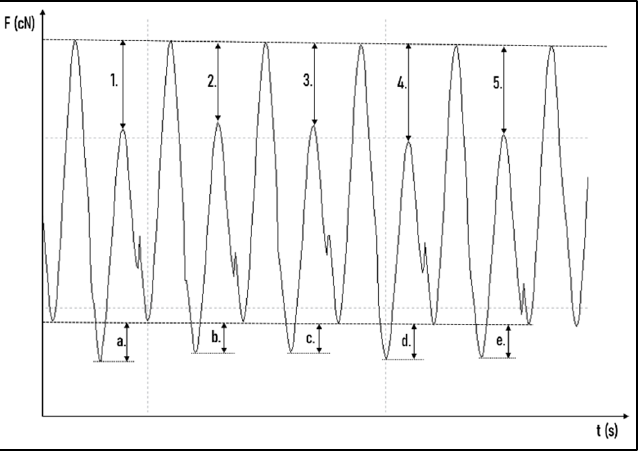
Figure 3. Determination of individual tensile forces. The tensile force of the first (1.), the second (2.), the third (3.), the fourth (4.), and the fifth (5.) ligature at 40 mm and the tensile force of the first (a.), the second (b.), the third (c.), the fourth (d.), and the fifth (e.) ligature at 15 mm.